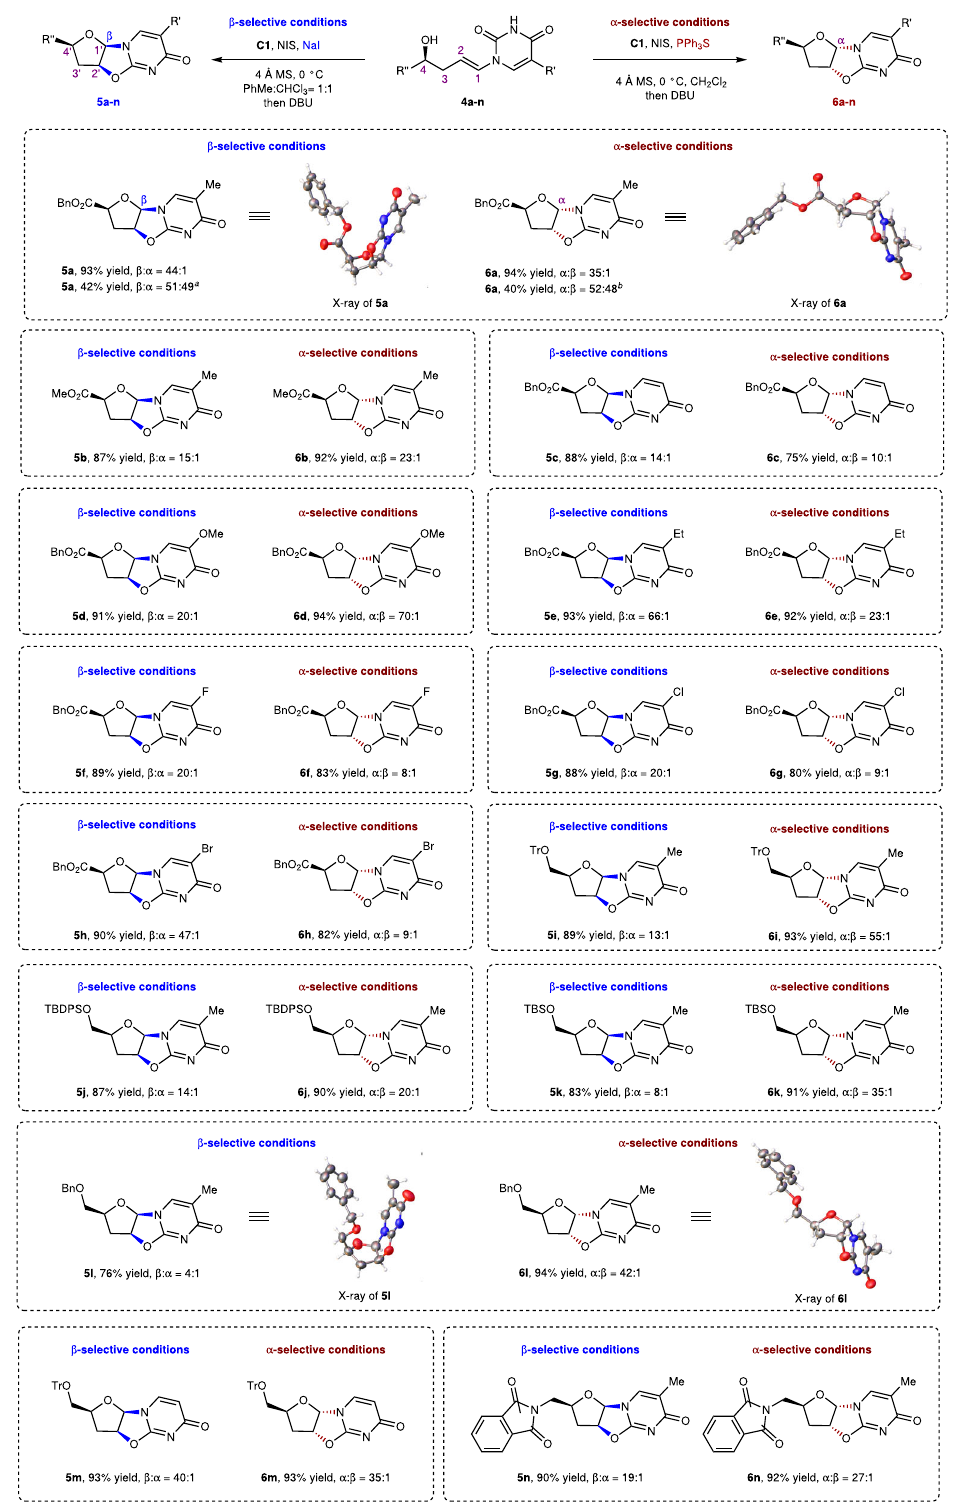
Fig. 3 | Substrate scope of nucleoside synthesis. a without NaI and C1 ; b without PPh 3 S and C1